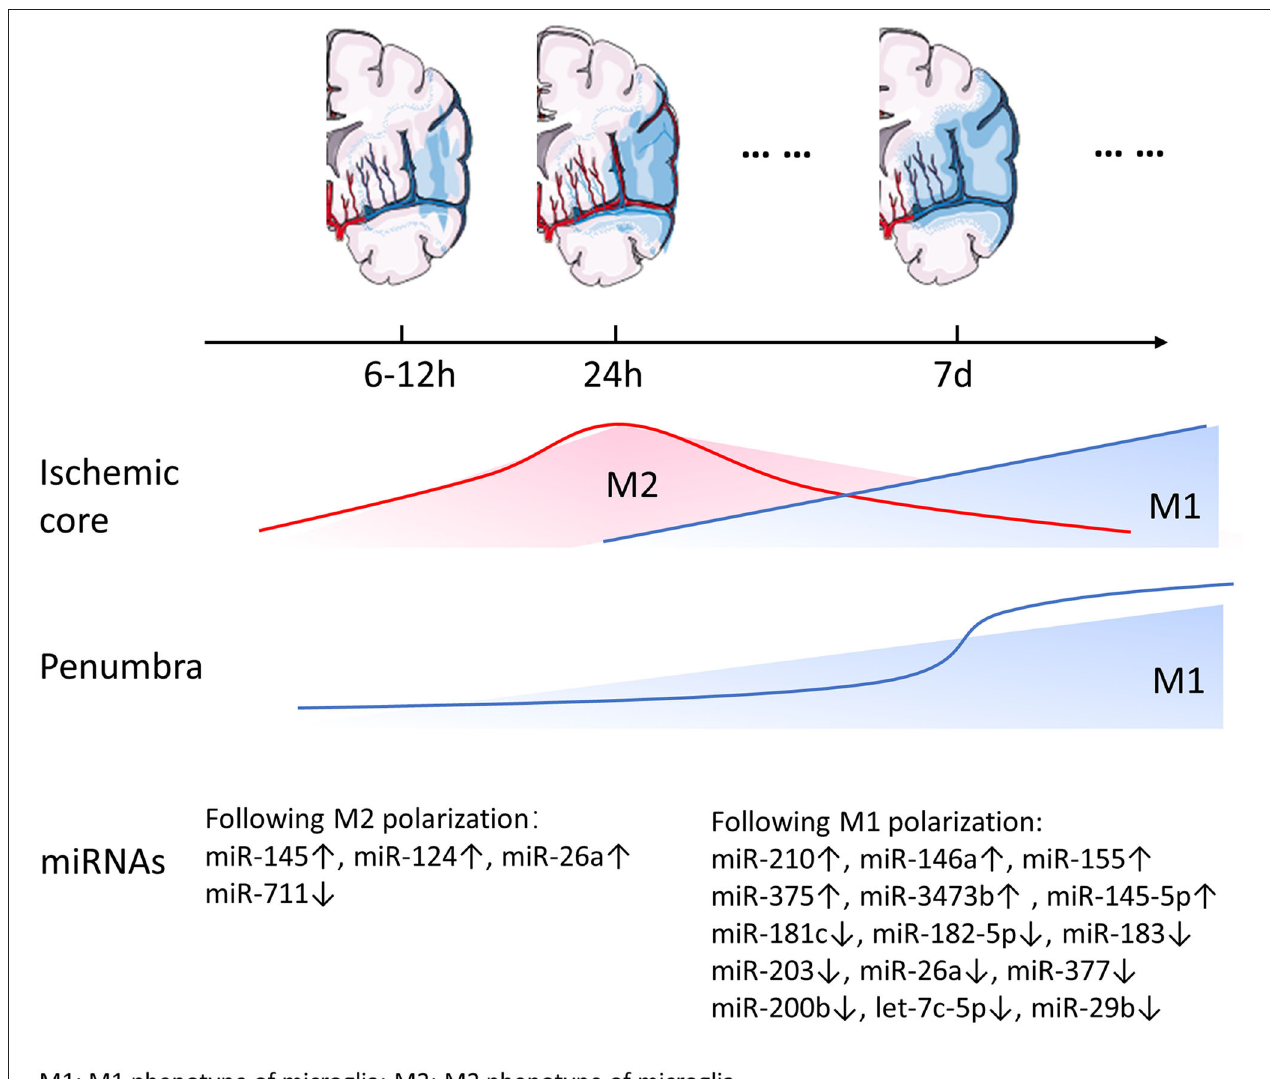
FIGURE 1 | Dynamic changes of miRNAs and microglia following ischemic stroke. Along with the expansion of the ischemic lesions, reactive microglia change dynamically with time and in space. M1 microglia appear to be strongly concentrated in the penumbra and rarely occur in ischemic core within 24h after stroke. At a later time point M1 microglia appear both in the penumbra and the ischemic core. It is worth noting that the number of M1 microglia increases dramatically 7 d after stroke. M2 microglia are exclusively expressed in the ischemic core in the acute phase of stroke and then gradually decrease. The expression of several miRNAs involved in microglial polarization changes over